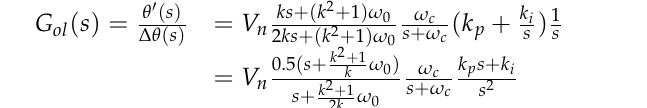
Figure 8. Small-signal model of CCF-MFOF-PLL.